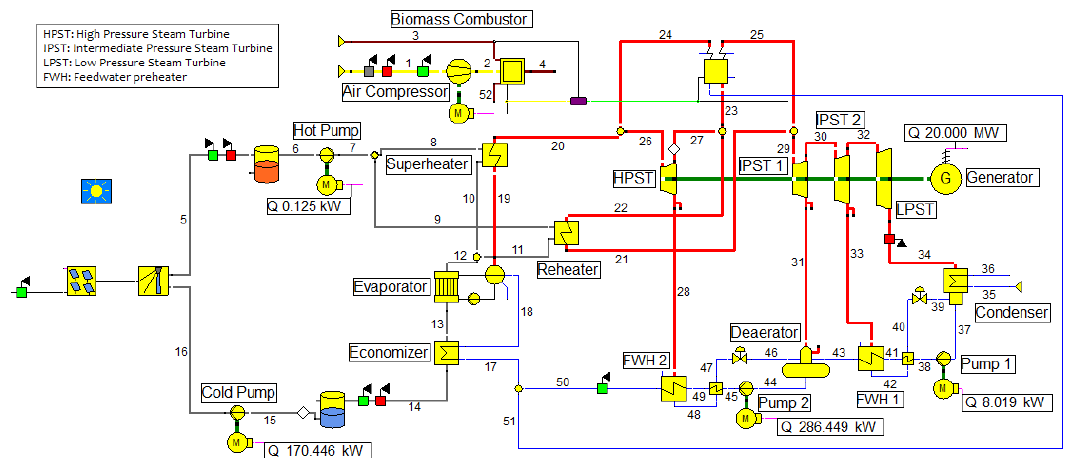
Figure 1. Diagram of the reference HPP. Table 1. Power block operational parameters.